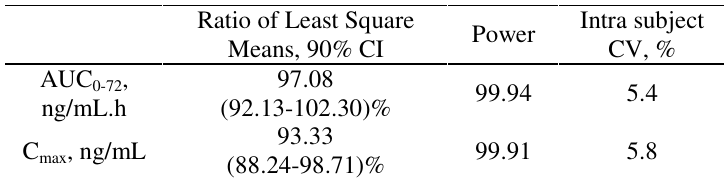
Table 3. Comparison T vs .